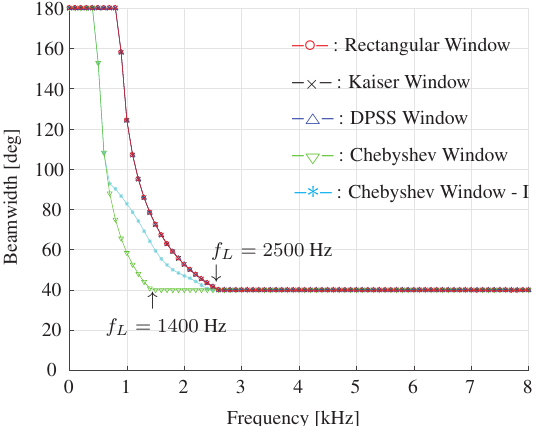
Figure 16. Beamwidth as a function of frequency for different window-based beamformers. The beamwidth is fixed to 40 ◦ , M = 11, δ = 3.5